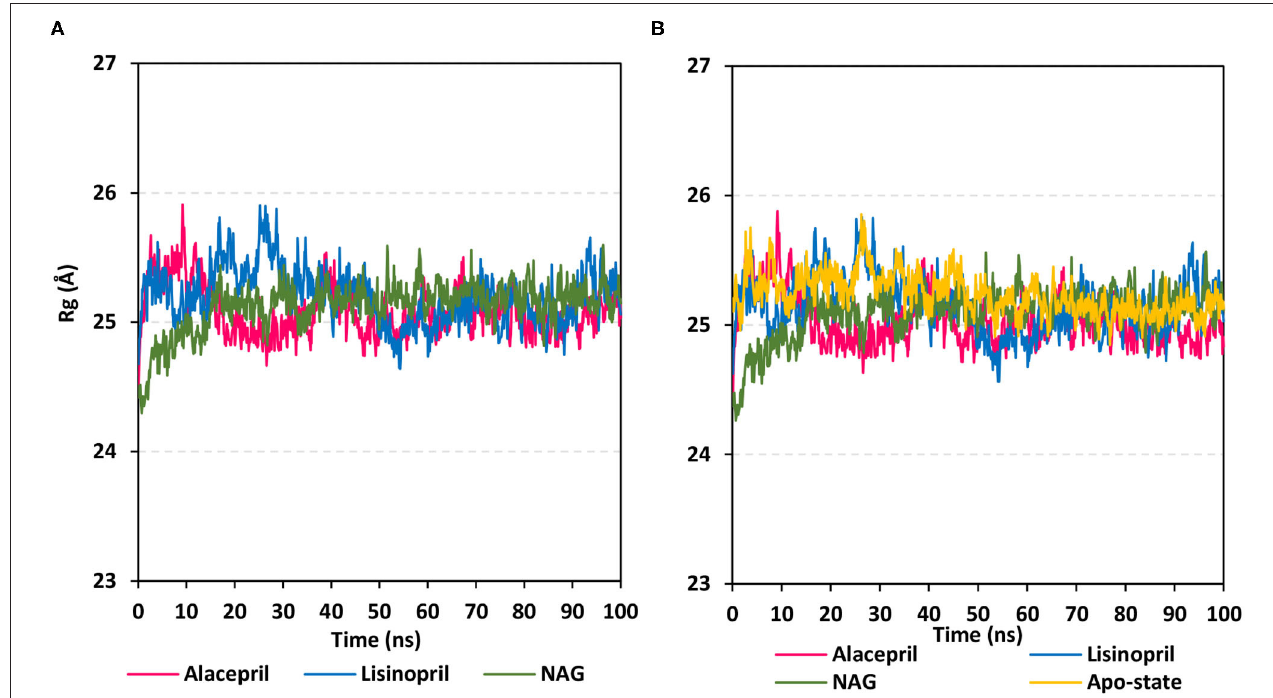
FIGURE 5 | Global stability analysis of ligand- h ACE2 protein complexes throughout 100 ns all-atom MD simulation. (A) Complex Rg; (B) protein Rg, vs. MD simulation time in nanoseconds. Alacepril/ h ACE2 and lisinopril/ h ACE2 complexes as well as glycosylated (NAG)-bound and apo-state (all glycans being removed) h ACE2 proteins are illustrated in pink, blue, green, and yellow colors, respectively.